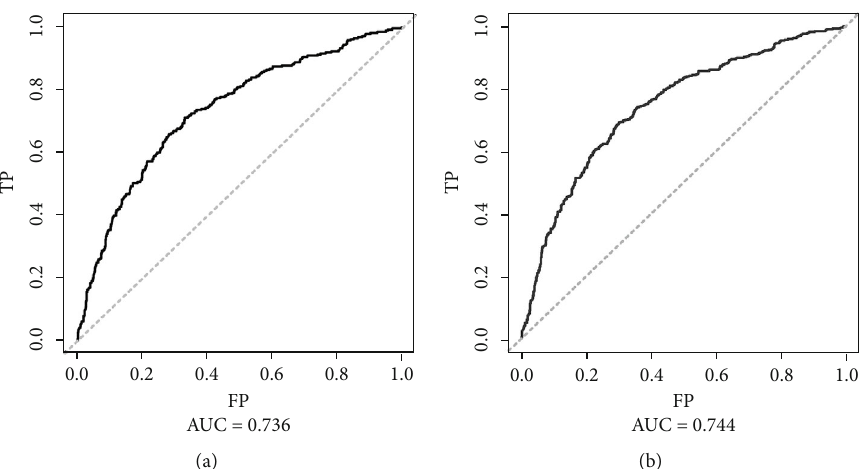
Figure 2: The ROC curves of internal validation: (a) The mortality that occurred within one year after admission to ICU; (b) the mortality that occurred within three years after admission to ICU.